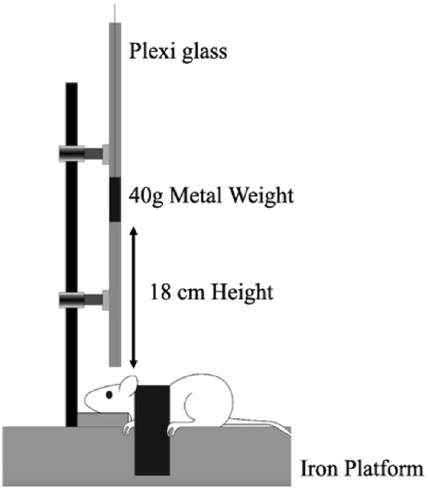
Figure 8. Scheme of TBI apparatus used to induce brain